Question: Draft a figure caption describing what is shown.
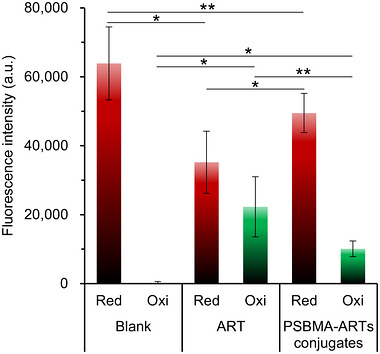
Answer: Brightness analysis of C11‐BODIPY reduced (Red) or oxidized (Oxi) in HepG2 cells, pretreated with or without artesunate (ART) alone or PSBMA‐ARTs conjugates. Both data are shown as the mean ± SD ( n = 10). Statistical significance was measured between two groups using unequal variances Welch's t‐test. ** p < 0.005, * p < 0.001.